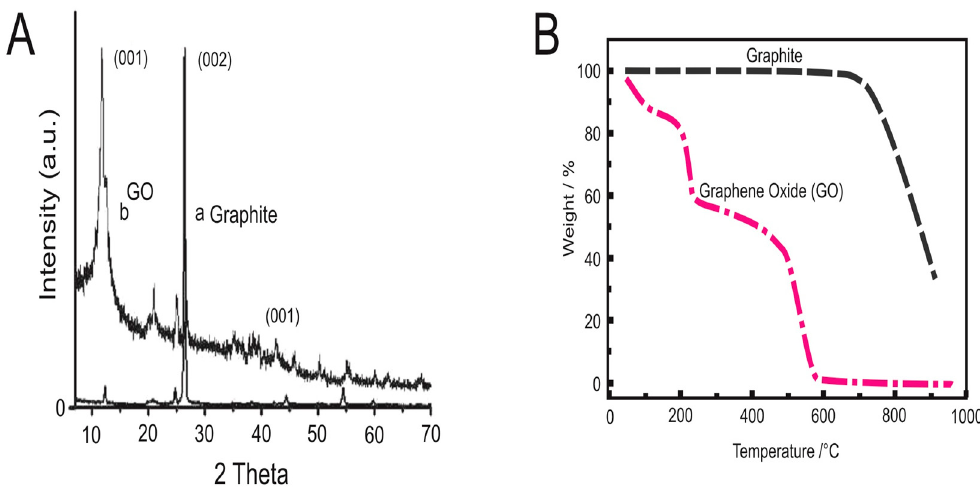
Figure 2. ( A ): XRD profiles of Graphite (a) and GO (b); ( B ): TGA curves for GO (pink curve line) and graphite (black curve line).